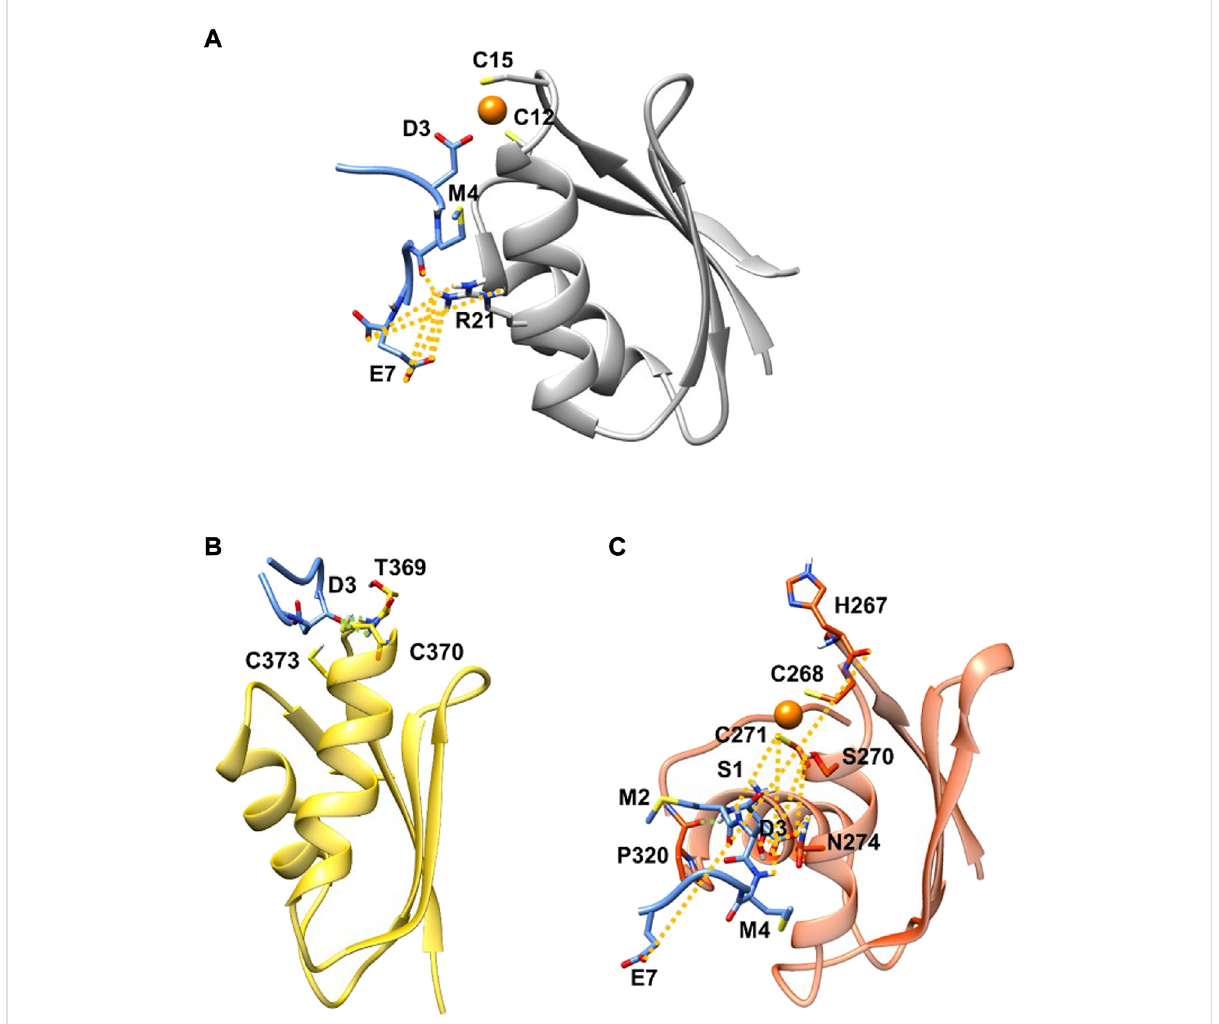
FIGURE 1 SMD(blue)incomplexwithAtox1 (A) (greynewcartoon),MBD4 (B) (yellownewcartoon),andMBD3 (C) (orangenewcartoon).Hydrogen-bonds are denoted as dotted lines in the same colour scheme as in Supplementary Table S2. Oxygen atoms are shown in red, nitrogen in blue, sulphur in yellow, polar hydrogen atoms in white, copper in orange, and carbon atoms in the colour scheme of the protein. Non-polar hydrogen atoms are omitted for